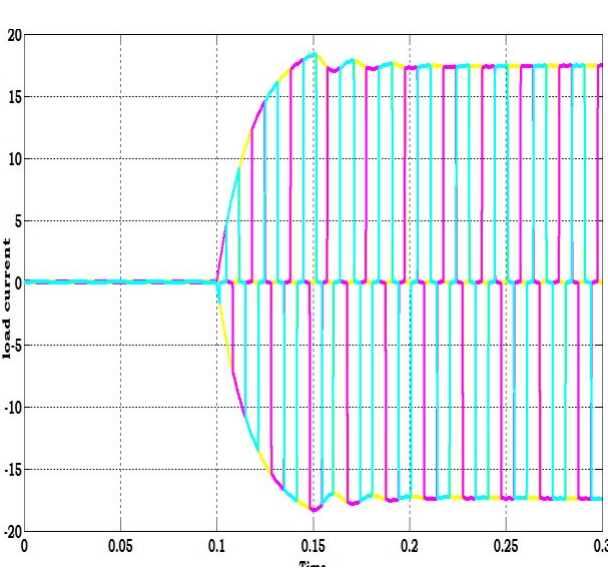
Figure 7. Waveform of Load Voltage